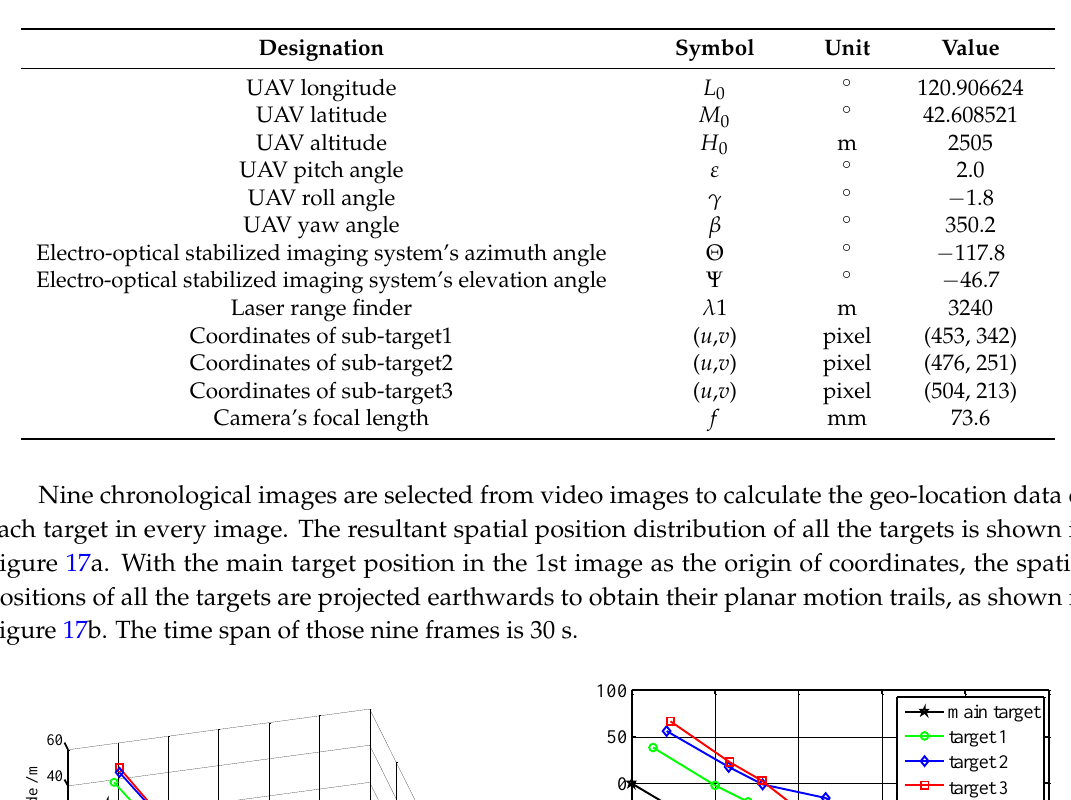
Table 8. Locations and attitudes data of electro-optical stabilized imaging system.